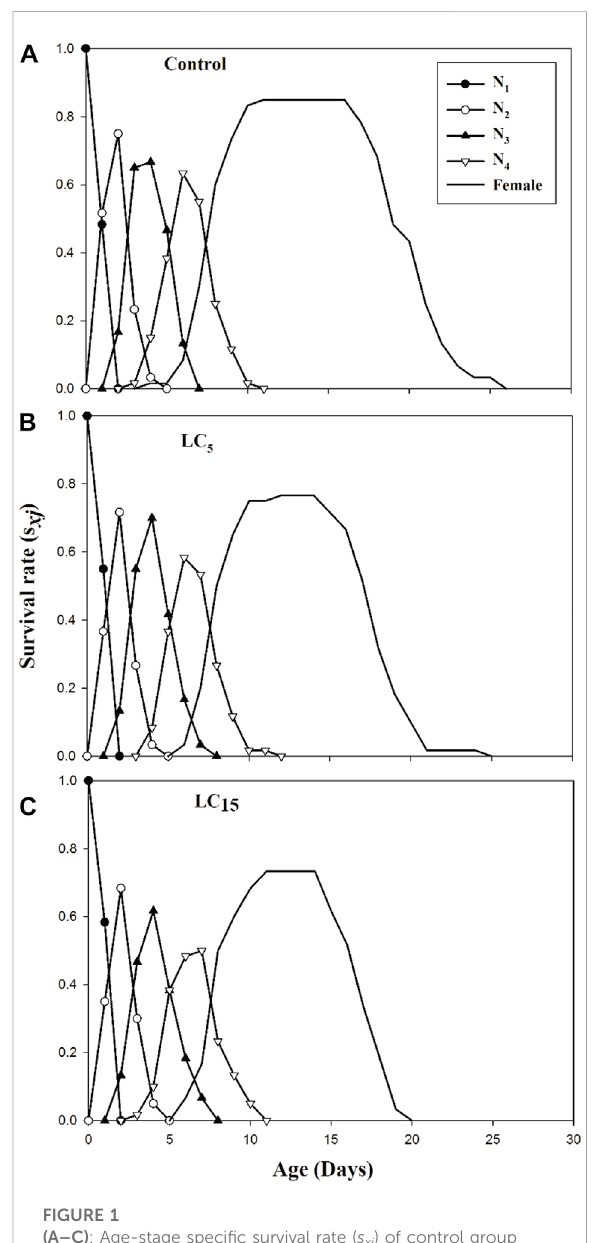
FIGURE 1 (A – C) : Age-stage speci fi c survival rate ( s xj ) of control group (A) and B. brassicae treated with LC 5 (B) and LC 15 (C) of Spirotetramat in F 1